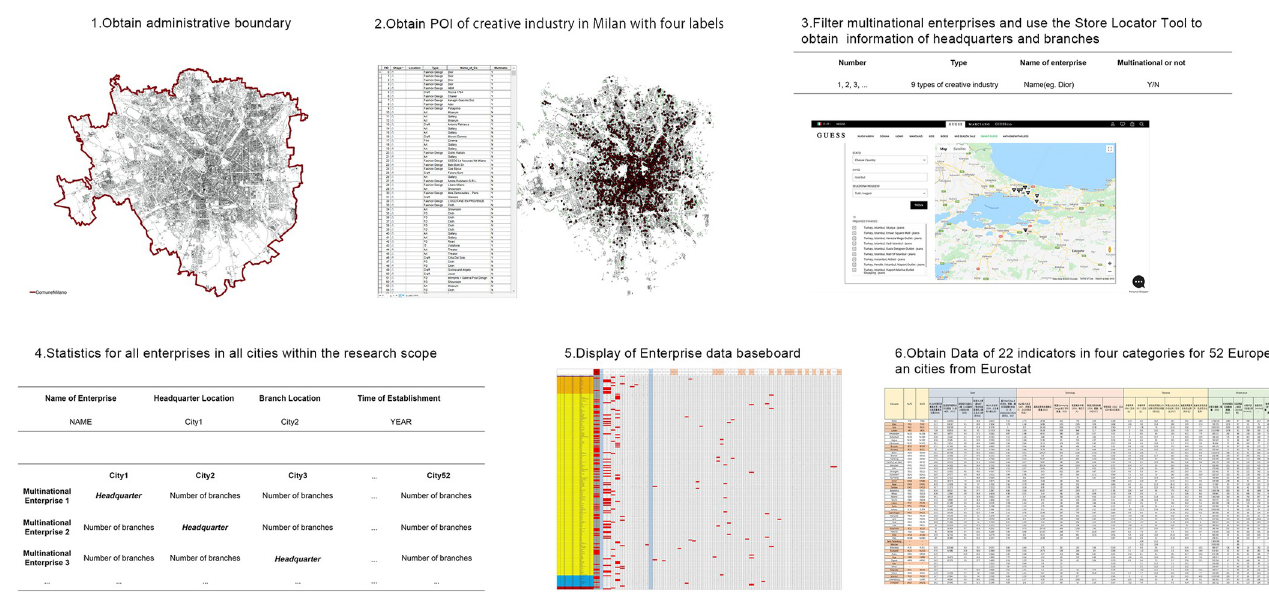
Fig 1. Data acquisition